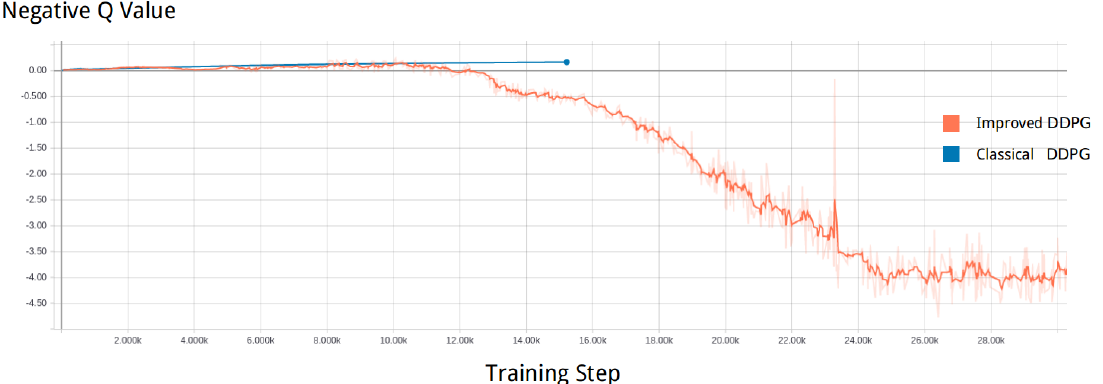
Figure 3. The negative Q value comparison between the improved deep deterministic policy gradient (DDPG) and the classical deep deterministic policy gradient(DDPG) and the classical DDPG of the single robot navigation